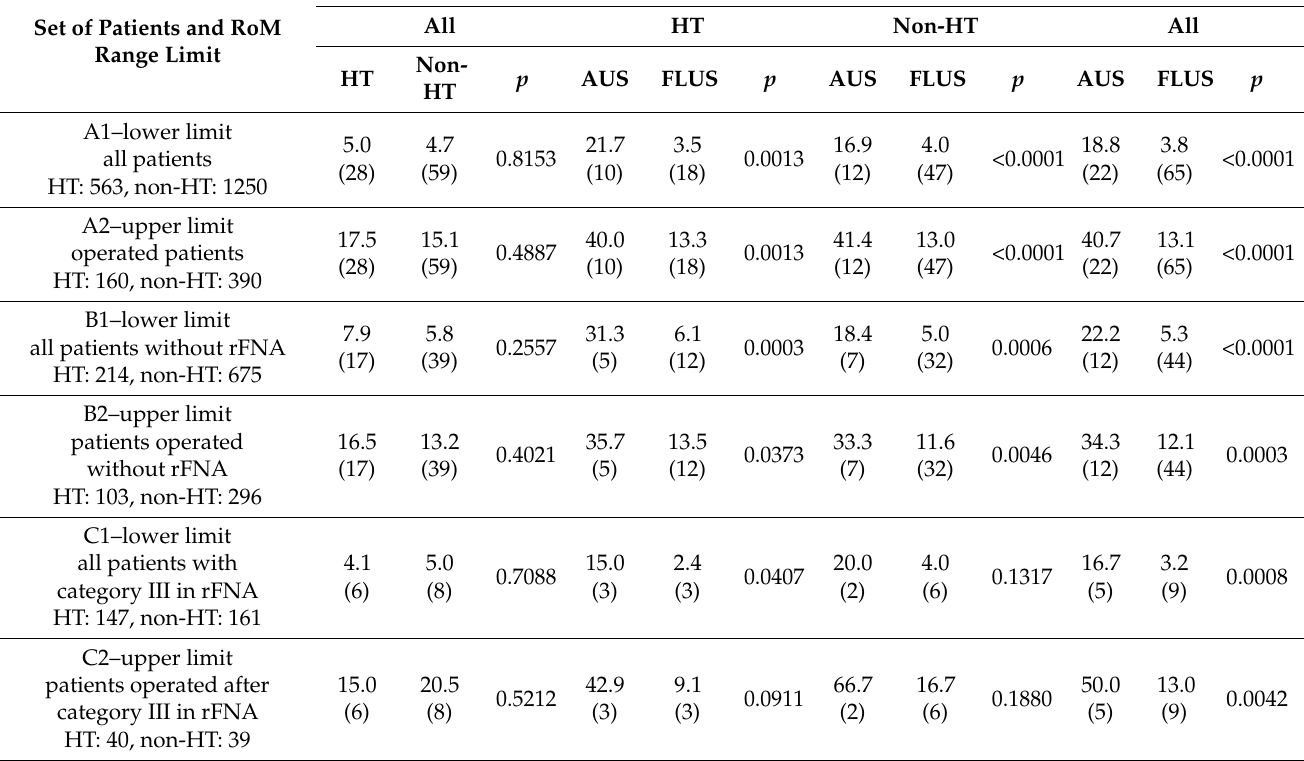
Table 5. Risk of malignancy (RoM) in patients from HT and non-HT groups with AUS and FLUS nodules analyzed in three sets of patients: (A) the whole examined cohort, (B) only patients without repeat FNA, and (C) only patients with category III in rFNA. RoM was evaluated as a range with its lower limit defined by the number of patients with cancer to the total number of patients (A1, B1 and C1) and its upper limit defined by the number of patients with cancer to the number of operated patients (A2, B2 and